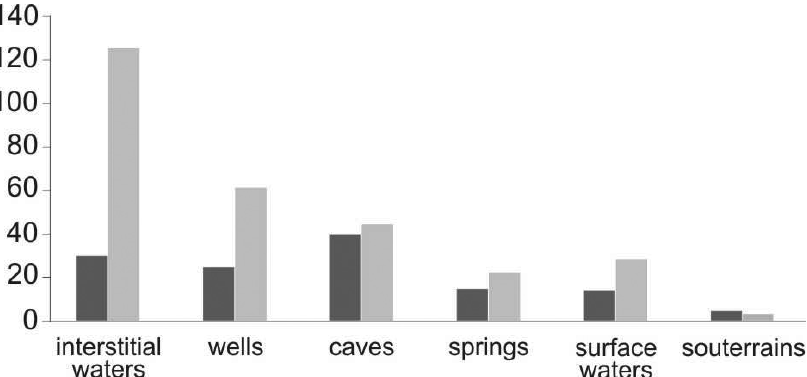
Figure 5. Number of studies performed in particular habitats (dark bar) and number of records of stygo- biontic species found in them (light